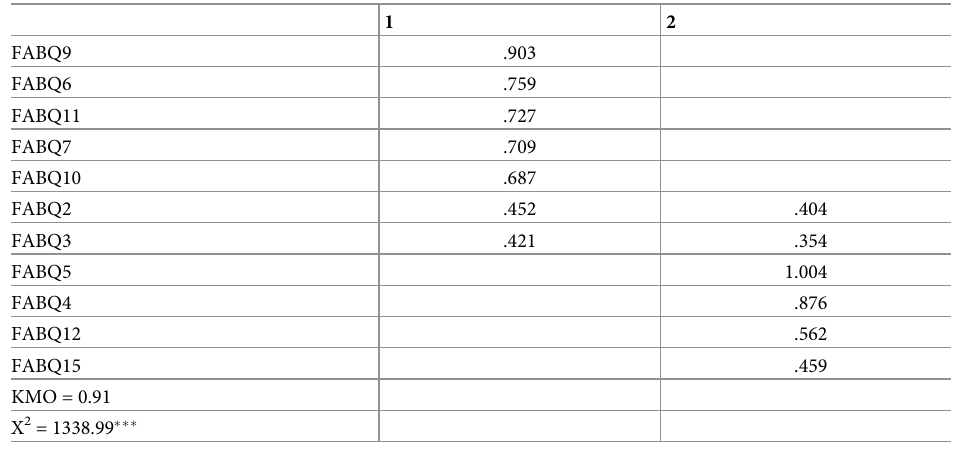
Table 6. Exploratory factor analysis of the Igbo-FABQ.